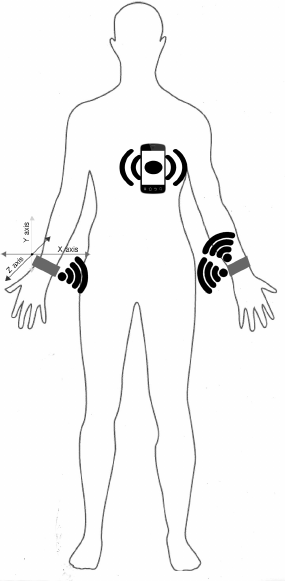
Figure 2. Attachment of Sensor nodes with accerometer x, y, z reading